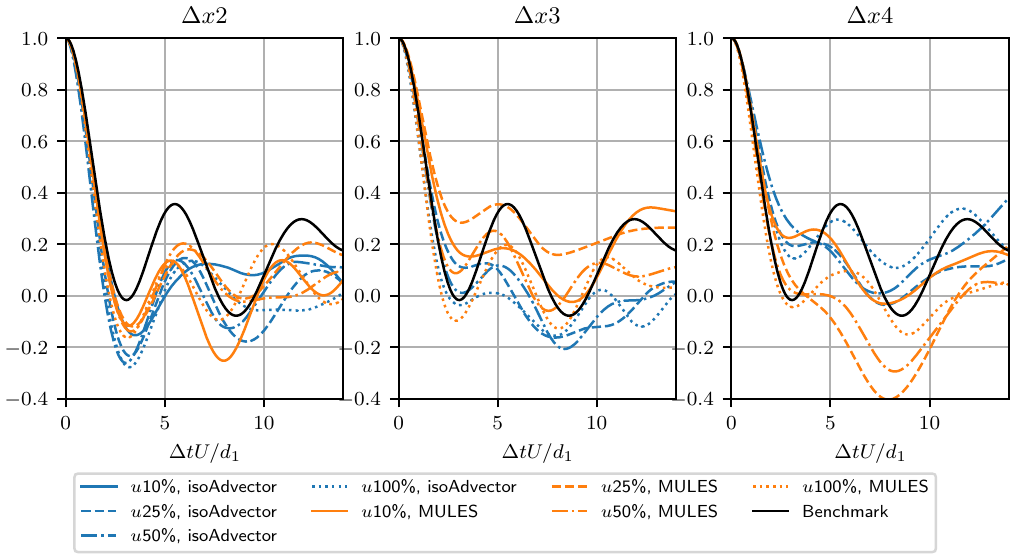
Figure 14. The spanwise velocity spectra obtained in the simulations at three selected locations: